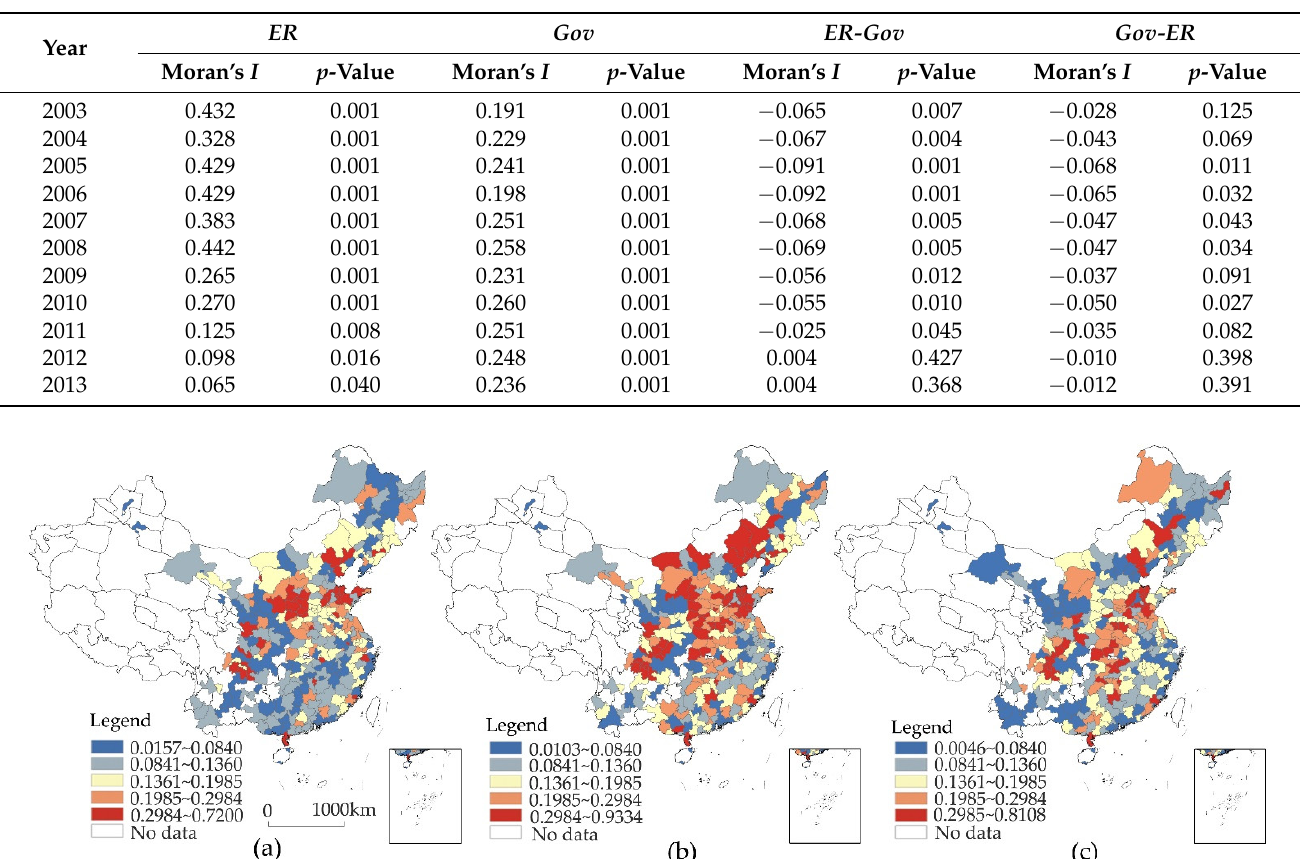
Figure 2. The spatial distribution and evolution of ER intensity. ( a ) The intensity of environmental regulation in 2003; ( b ) the intensity of environmental regulation in 2008; ( c ) the intensity of environ- mental regulation in 2013. Table 2. Univariate and bivariate global Moran’s I statistics for ER and LP. Table 2. Univariate and bivariate global Moran’s I statistics for ER and LP.